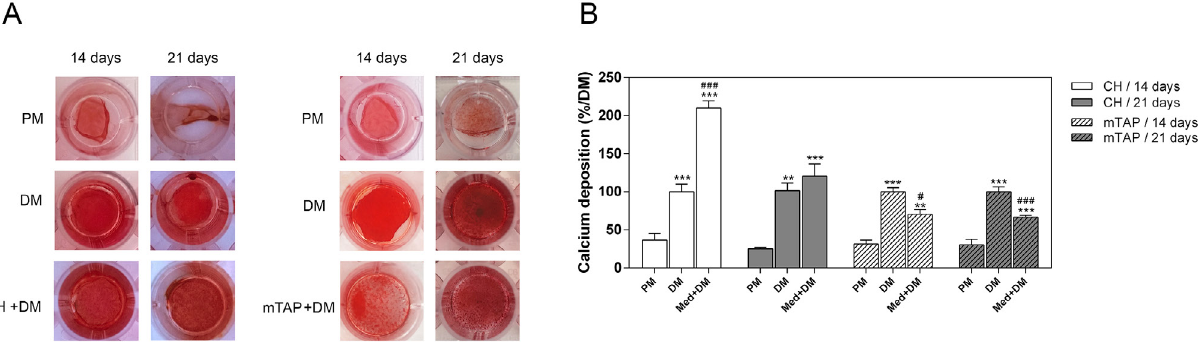
Figure 3- Mineralization potential of APC assessed through calcium deposition by using Alizarin Red S staining. Once kept in contact with CH or mTAP at 250 µg/mL for 5 days, osteogenic mineralization was induced for 14 and 21 days. A – macroscopic view of wells after staining; and B – quantification of calcium eluates normalized by positive control (DM). PM: proliferation medium, DM: differentiation medium; CH + DM and mTAP + DM: calcium hydroxide or mTAP prior to mineralization; Med + DM: medication prior to mineralization. **P<0.01 and ***P<0.001 in comparison to PM; #P<0.05 and ###P<0.001 in comparison to DM